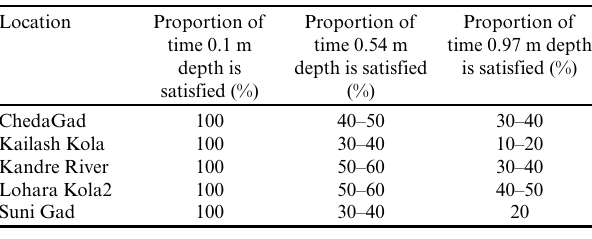
Table 4. Satisfaction of the minimum social flow requirement by the designed environmental flow